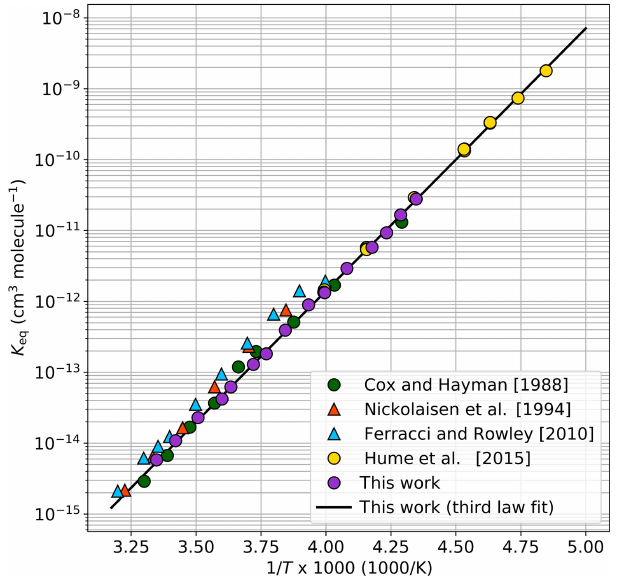
Figure 4. K eq values as a function of 1000 /T . The black trace is the third-law fit as determined in Fig. 3, K eq = 2 . 16 × 10 − 27 e ( 8527K /T) cm 3 molecule − 1 . For clarity, data from this work are plotted as 3K averages (purple circles) of the full data set shown in Fig. 3. The colored markers are K eq values from prior laboratory studies as reported in the literature.